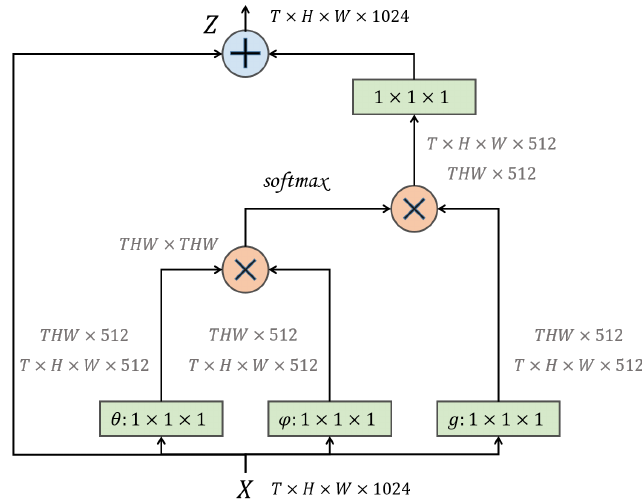
Figure 3. A spacetime non-local block [78]. If we suppose that the size of the input feature map is T × H × W × 1024, where means 1024 channels, then “ ⊗ ” denotes matrix multiplication and “ ⊕ ” denotes element-wise summation. The green boxes denote 1 × 1 × 1